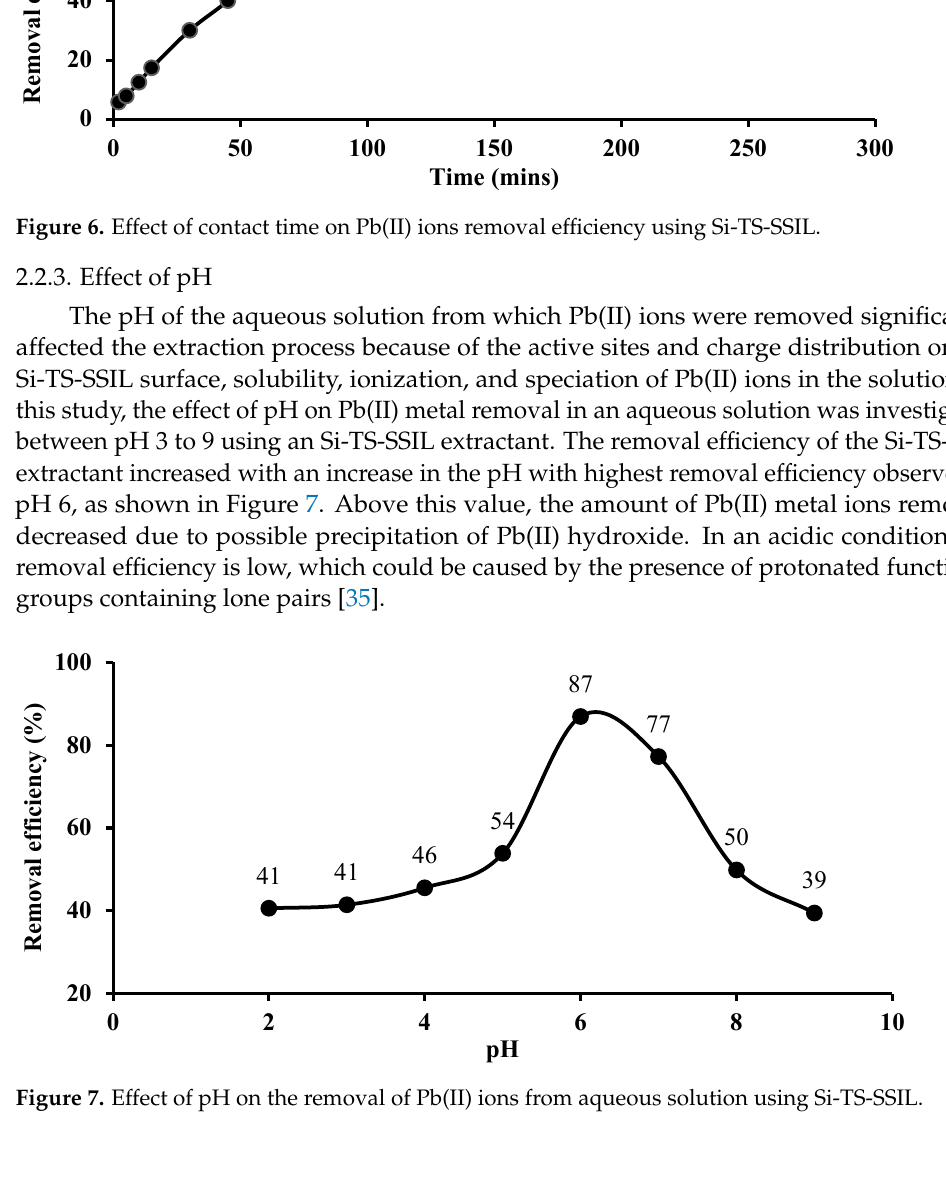
8 of 18 Figure 5. The effect of different [MTMSPI][TS]:activated silica gel mass ratios on the removal process of Pb(II) ions onto Si-TS-SSIL. 2.2.2. Effect of Contact Time